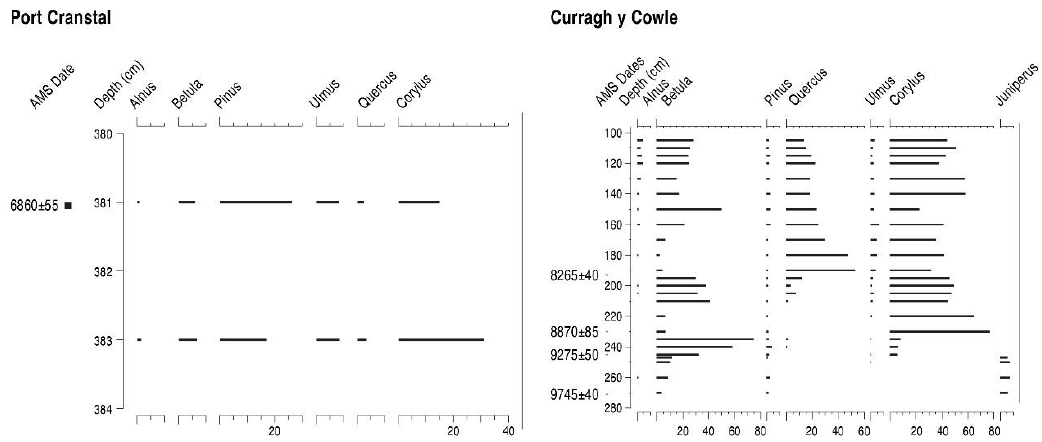
Figure 3. Percentage pollen diagrams from Port Cranstal and Curragh y Cowle, Isle of Man, showing selected tree taxa and 14 C BP AMS ages.